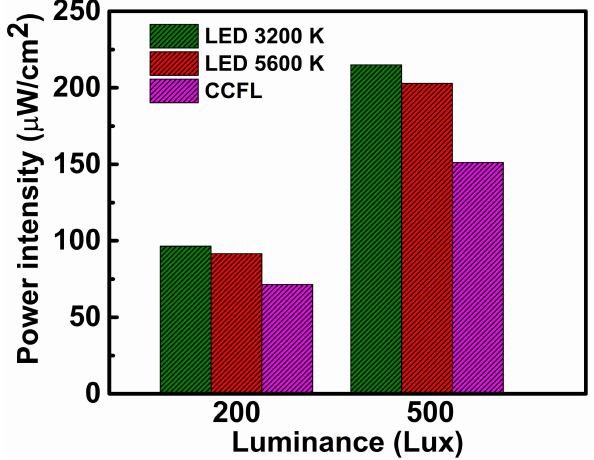
Figure 1. ( a ) Irradiance spectra of di ff erent indoor light sources. (Reproduced from [13,34], with permission from Elsevier, 2019 and Elsevier, 2016 respectively); ( b ) Solar spectra (AM1.5G). (Reproduced from [44], with permission from Elsevier, 2006).